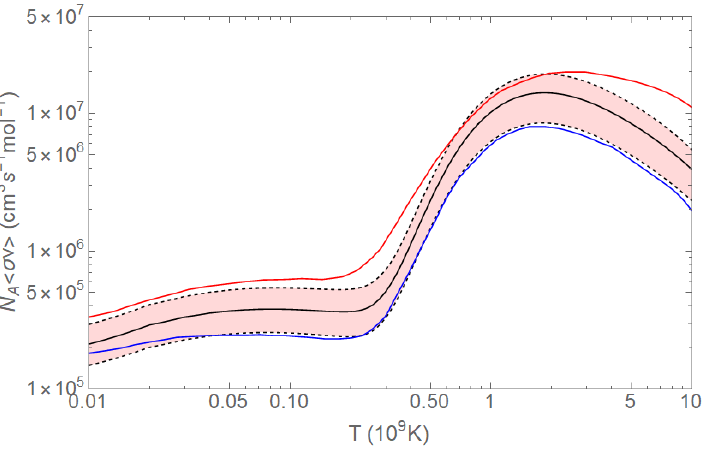
Figure 11. THM reaction rate for the 17 O(n, α ) 14 C reaction (black line) in comparison with the ones available in the literature (see text for